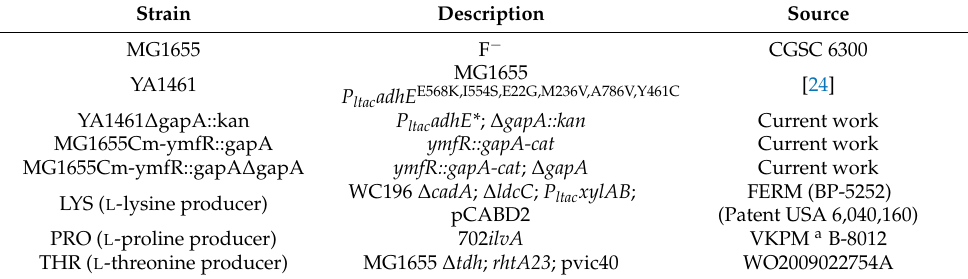
Table 1. E. coli strains used in this study.